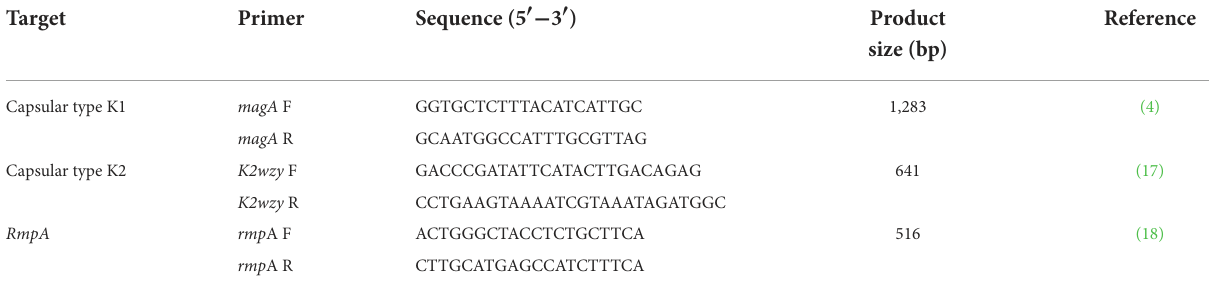
TABLE 1 Primer information for each target